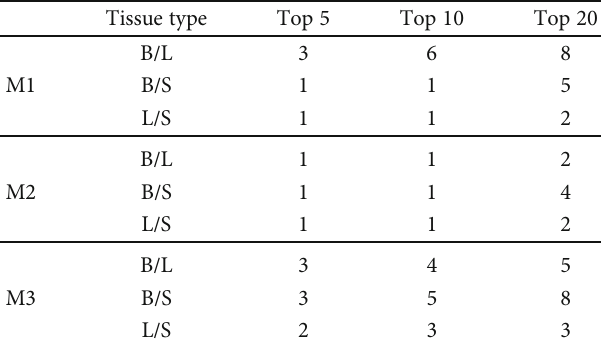
Table 4: The number of overlapped CDR3 sequences of tissues, lung metastatic tissues, and spleens from 4T1 tumor- bearing BALB/c